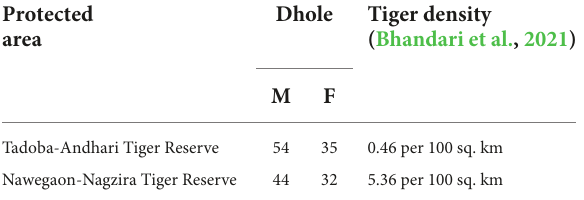
Dhole Tiger density (Bhandari et al., 2021)